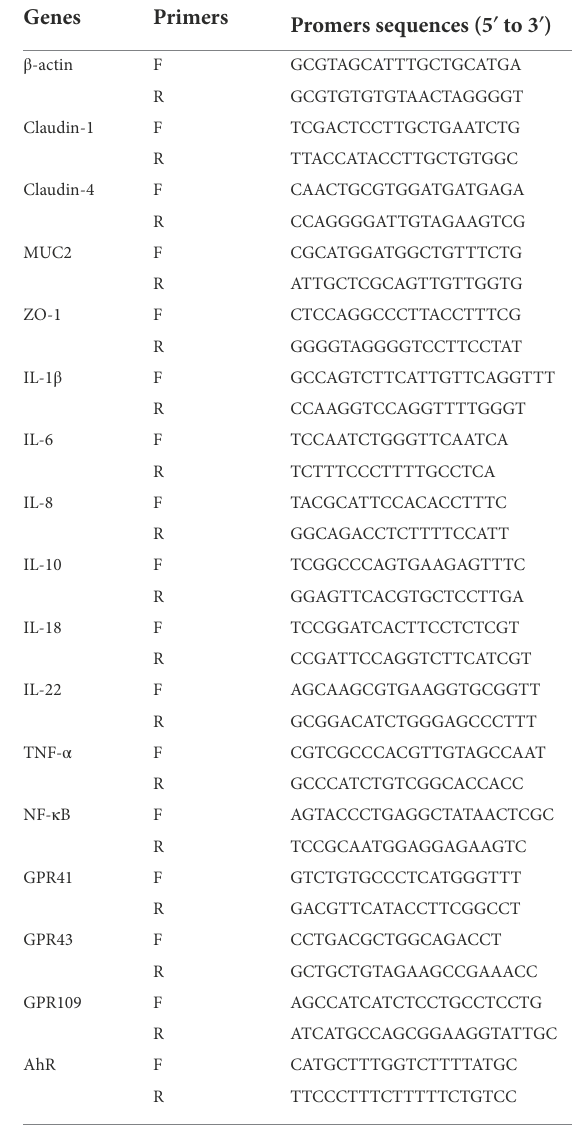
TABLE 2 Primers used for real-time quantitative PCR